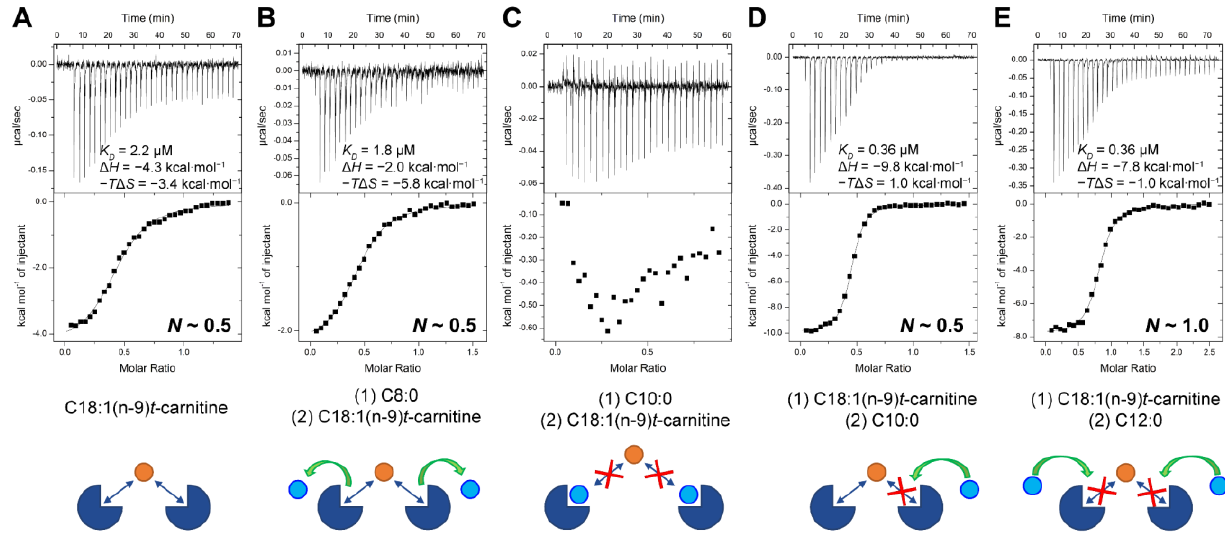
Figure 9. Top. Competitive binding studies of heart-type fatty acid-binding protein (FABP3)-C18:1(n-9) t -carnitine and three fatty acids (FAs) of different chain lengths. ( A ) Reference titration of C18:1(n-9) t -carnitine to apo-FABP3. ( B ) FABP3-C8:0 complex titrated with C18:1(n-9) t -carnitine. ( C ) FABP3-C10:0 complex titrated with C18:1(n-9) t -carnitine. ( D ) FABP3-C18:1(n-9) t -carnitine complex titrated with C10:0. ( E ) FABP3-C18:1(n-9) t -carnitine complex titrated with C12:0. All experiments were performed in 20 mM K 2 HPO 4 /KH 2 PO 4 and 50 mM KCl buffer pH 7.6 (KPi) at 25 °C. Bottom. Schematic representation of ligand binding and competition. Protein is represented as the dark blue sector, acylcarnitines (ACs) as orange, and FAs as cyan circles. Green arrows indicate that the competition event between ligands was successful.